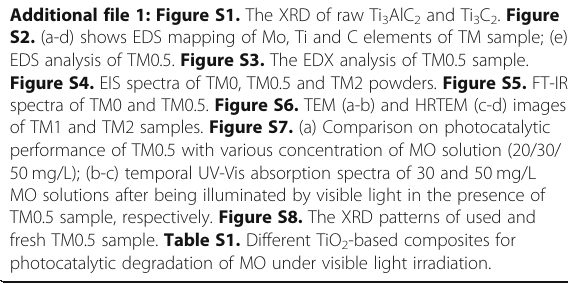
Additional file 1: Figure S1. The XRD of raw Ti 3 AlC 2 and Ti 3 C 2 . Figure S2. (a-d) shows EDS mapping of Mo, Ti and C elements of TM sample; (e) EDS analysis of TM0.5. Figure S3. The EDX analysis of TM0.5 sample. Figure S4. EIS spectra of TM0, TM0.5 and TM2 powders. Figure S5. FT-IR spectra of TM0 and TM0.5. Figure S6. TEM (a-b) and HRTEM (c-d) images of TM1 and TM2 samples. Figure S7. (a) Comparison on photocatalytic performance of TM0.5 with various concentration of MO solution (20/30/ 50mg/L); (b-c) temporal UV-Vis absorption spectra of 30 and